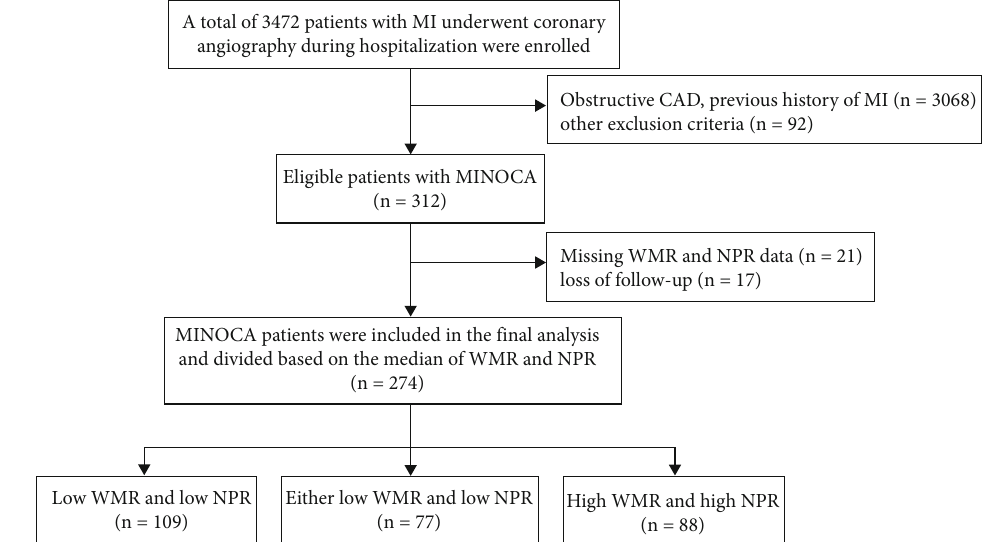
Figure 1: Flowchart of the study selection process. MI: myocardial infarction; CAD: coronary artery disease; MINOCA: myocardial infarction with nonobstructive coronary arteries; WMR: white blood cell count to mean platelet volume ratio; NPR: neutrophil-to- platelet